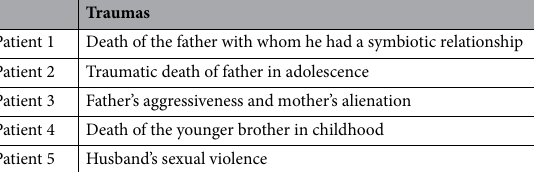
Table 4. Traumas preceding first syncope events detected during psychotherapeutic